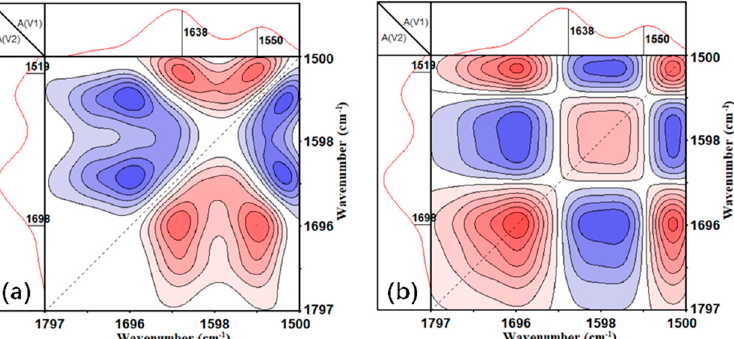
Figure 9. The synchronous ( a ) and asynchronous spectroscopy ( b ) of ATR − FTIR for CoPA − 12 in a wavenumber range from 1500 to 1797 cm − 1 .